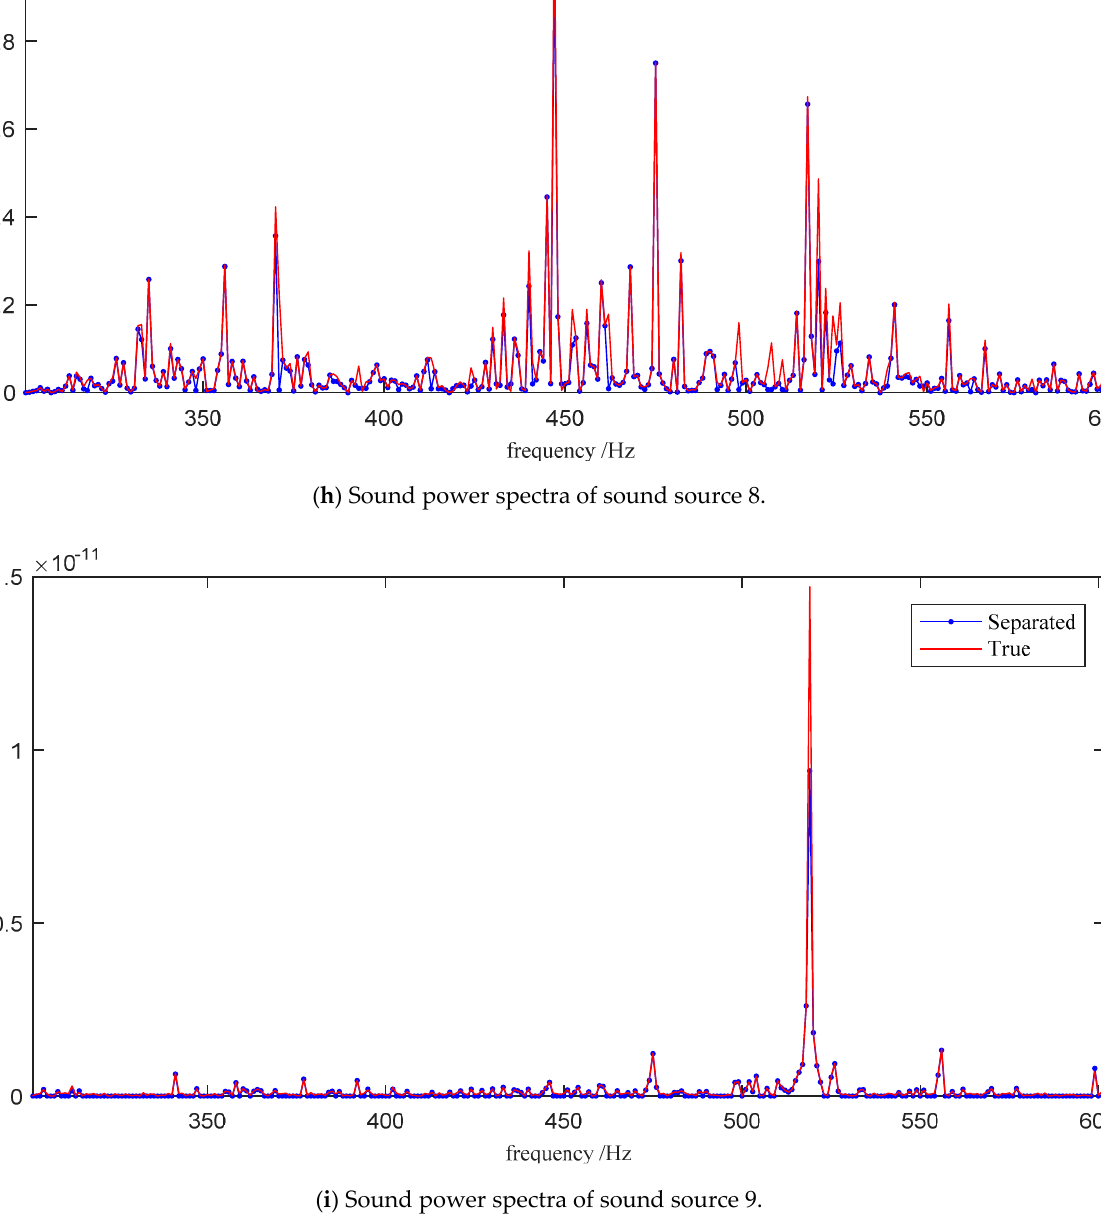
Figure 5. The comparison of the separated and the true sound power spectra of the nine sound sources. The sound power spectra of the nine sound sources calculated by the sound intensity small at the frequencies with higher intensity.